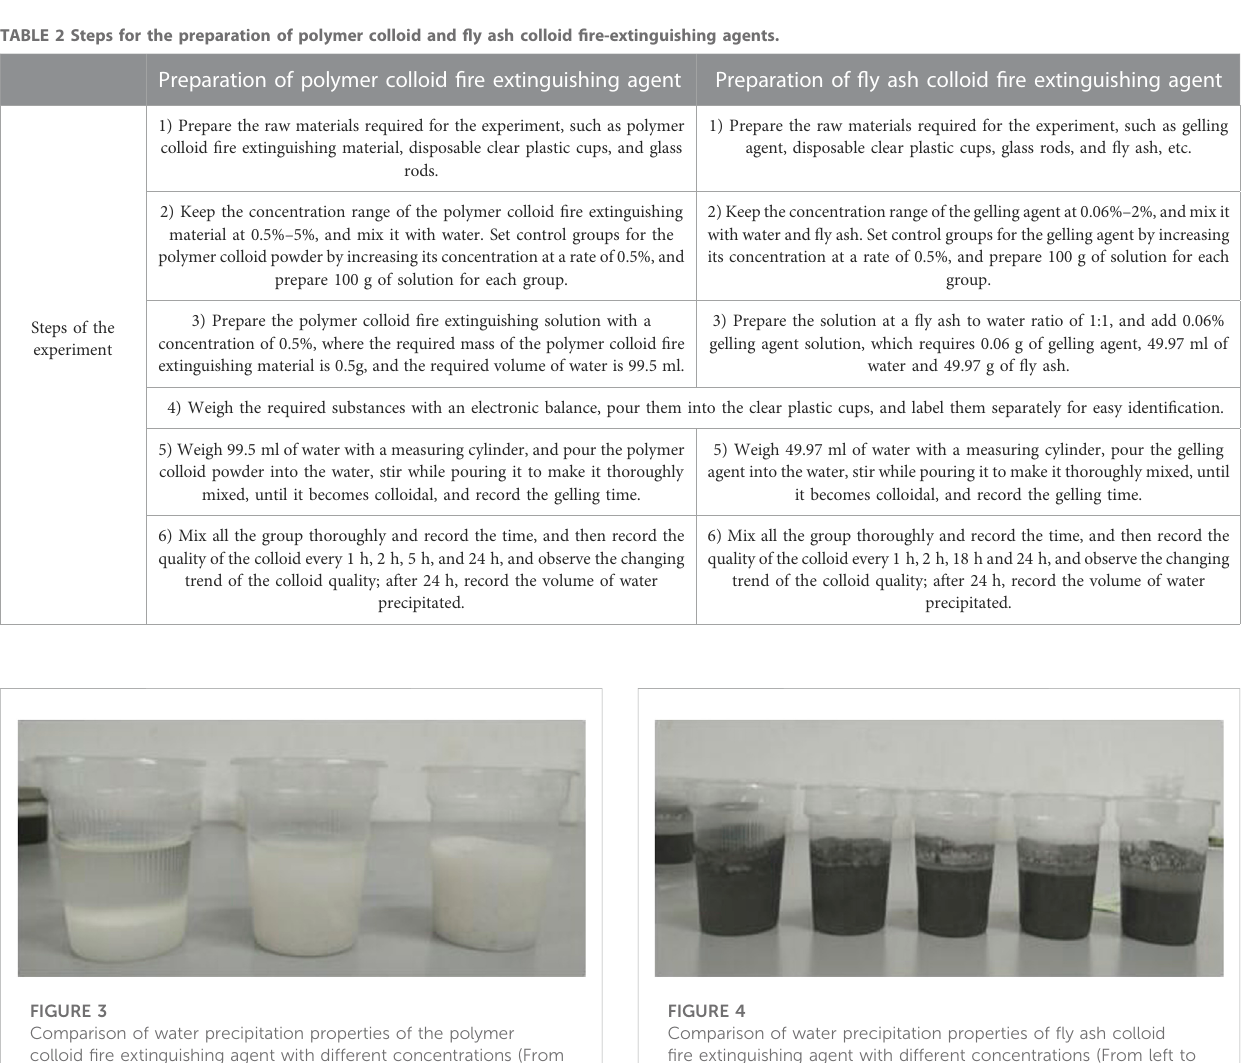
TABLE 1 Experimental materials required for preparation of polymer colloid and fl y ash colloid fi re extinguishing agents. Preparation of polymer colloid fi re extinguishing agent Preparation of fl y ash colloid fi re extinguishing agent Experimental materials